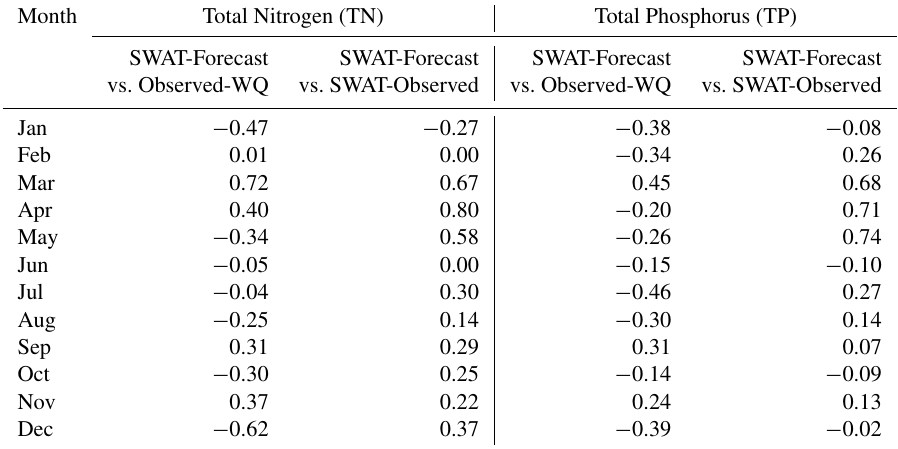
Table 5. Monthly comparison of temporal correlation coefficient (TCC) according to different references as